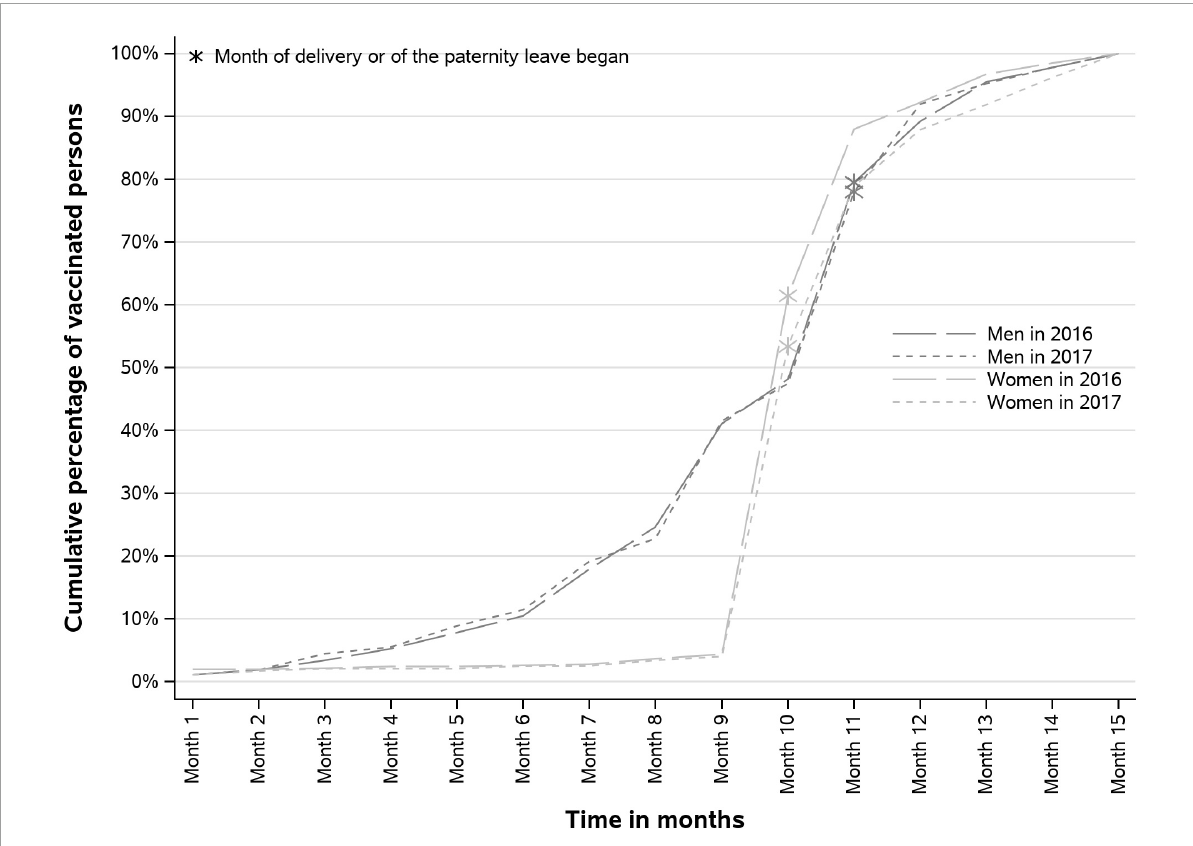
FIGURE3 Cumulative vaccination coverage rates (VCR) during the “parental project” period, according to the month of the “parental project.”